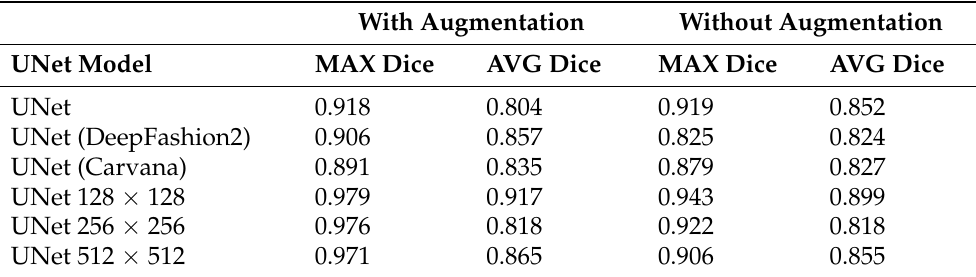
Table 2. Different UNet models’ 5 run validation results including maximum and average values of Dice coefficients.